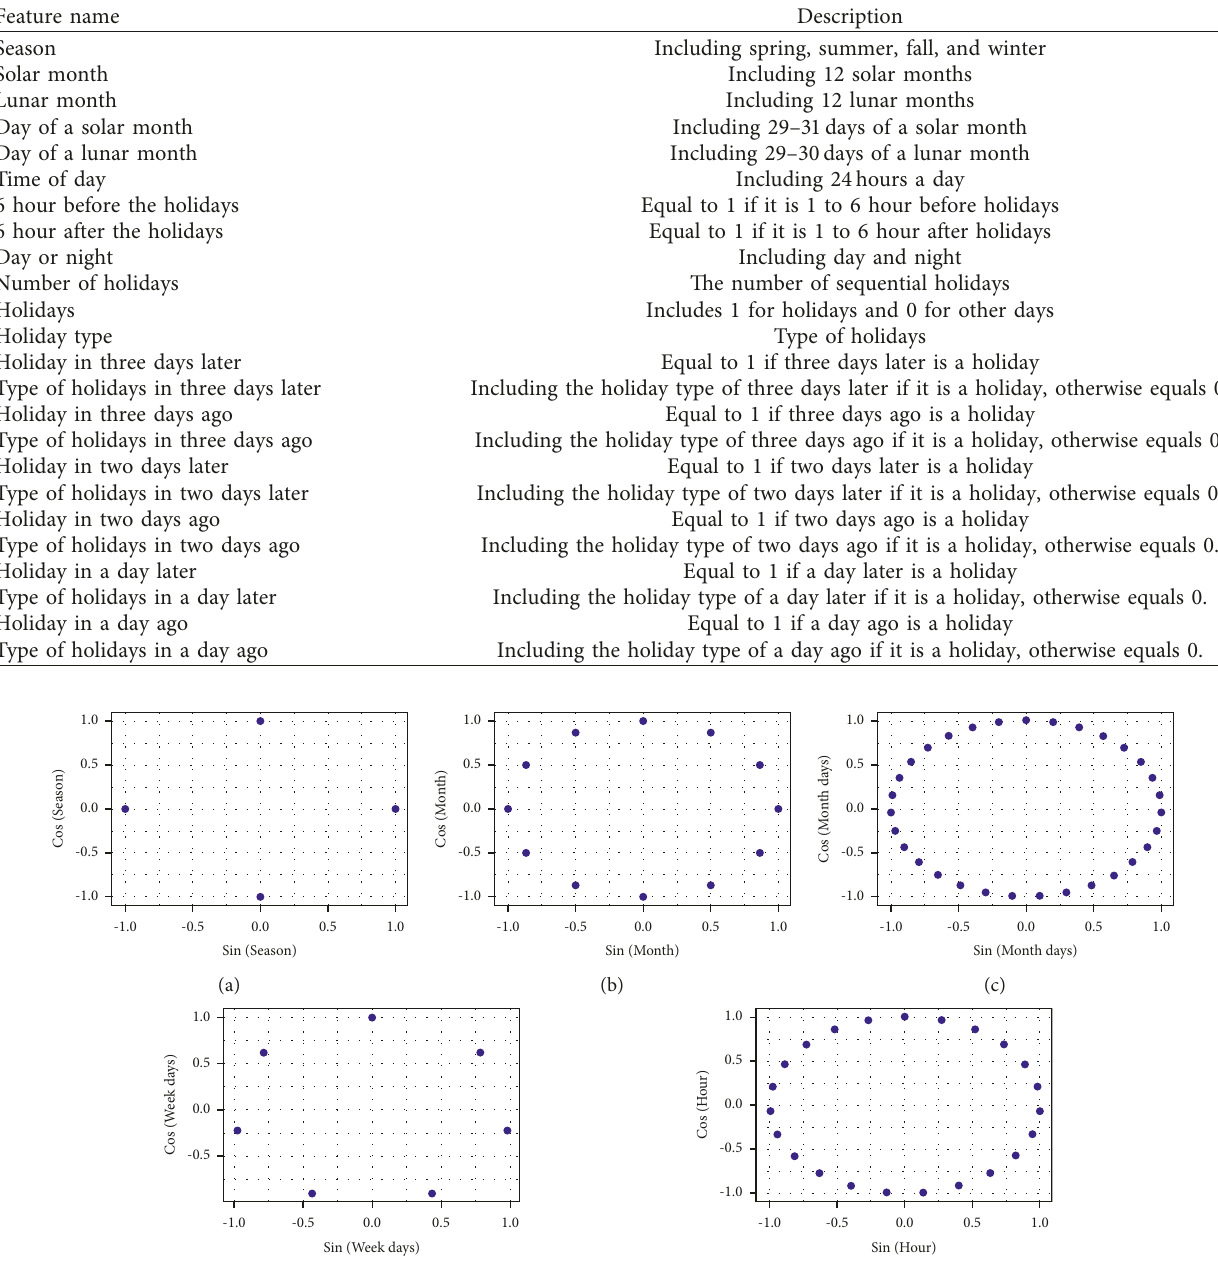
Table 1: Description of candidate features to predict traffic flow.